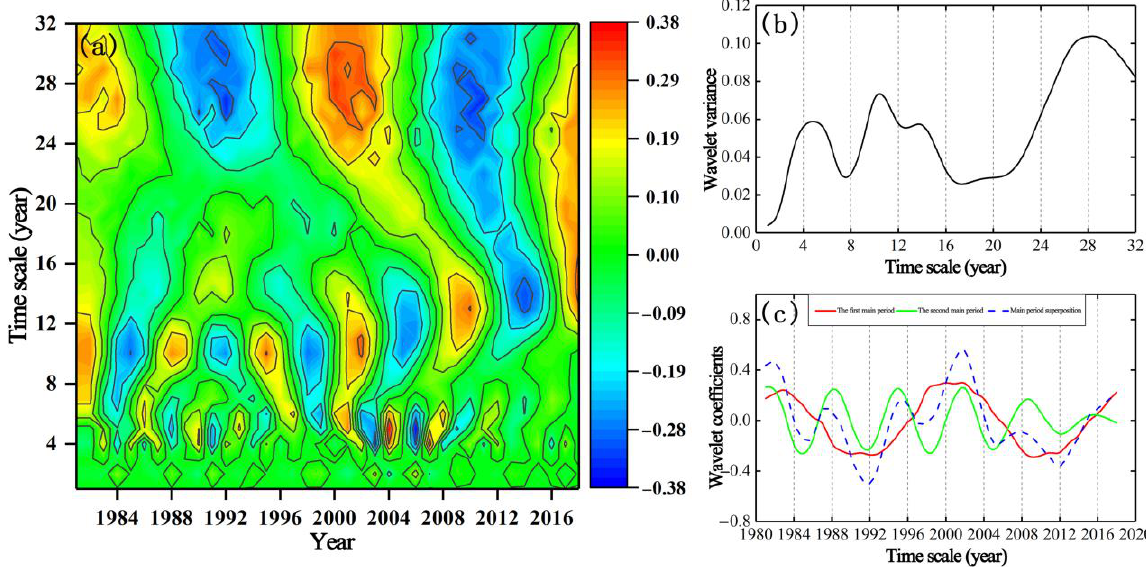
Figure 8. Periodicity characteristics of drought in the whole growth stage of spring maize in the Songnen Plain from 1981 to 2018: ( a ) the real part contour of wavelet coefficients; ( b ) wavelet variance; and ( c ) wavelet coefficients.